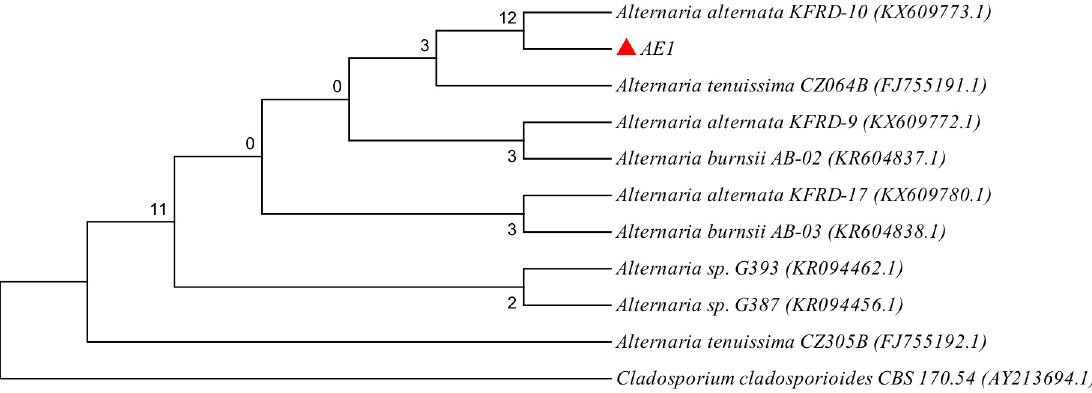
PLOS ONE | https://doi.org/10.1371/journal.pone.0214744 April 4,